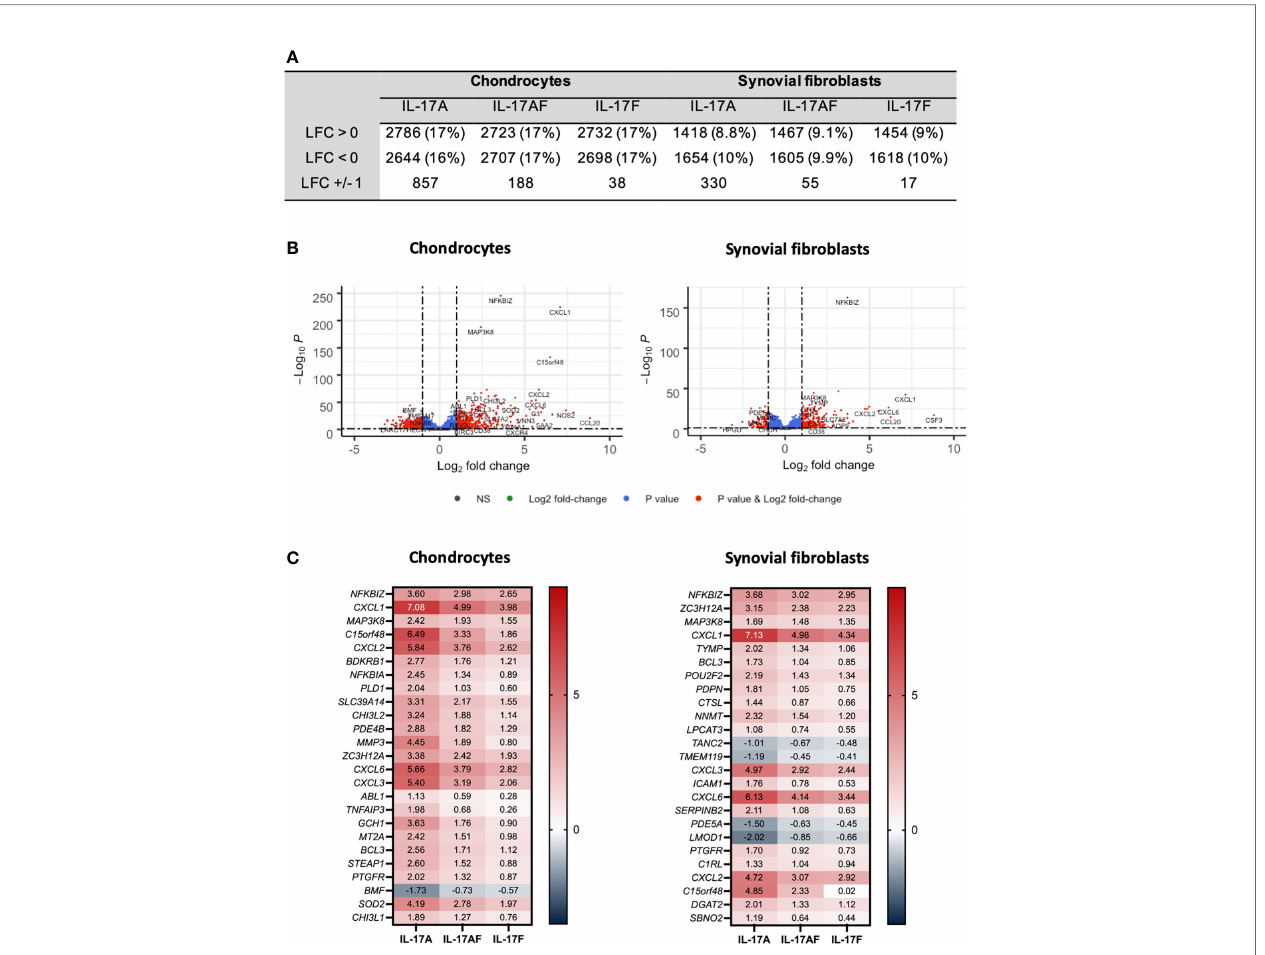
FIGURE 2 | Changes in gene expression after treatment with IL-17A, IL-17AF, or IL-17F compared to vehicle control measured by bulk RNA-Seq. (A) Overview of changes induced by IL-17 cytokines (padj<0.05). (B) Volcano plots showing the changes in gene expression after treatment with IL-17A in chondrocytes (left) and synovial fi broblasts (right). Grey = not signi fi cant (NS); green = Log2 fold change of at least 1 or -1, but p>0.05; blue = p-value < 0.05, but log2 fold change >-1 and <1; red = p-value<0.05 and log2 fold change of at least -1 or +1. (C) Heatmap of the 25 most signi fi cantly differentially expressed genes by chondrocytes (left) and synovial fi broblasts (right). Red = upregulated, blue = downregulated.